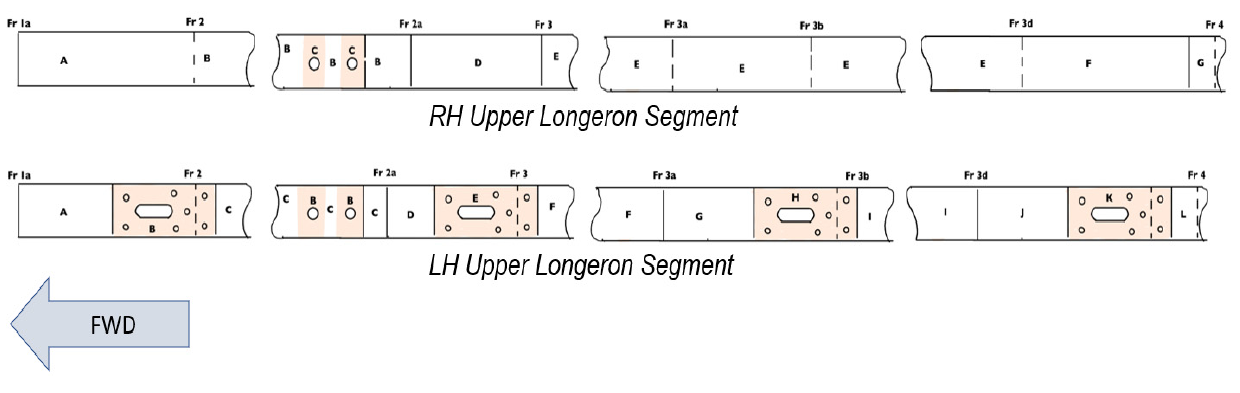
Figure 14. Segments on the longeron for inspection.